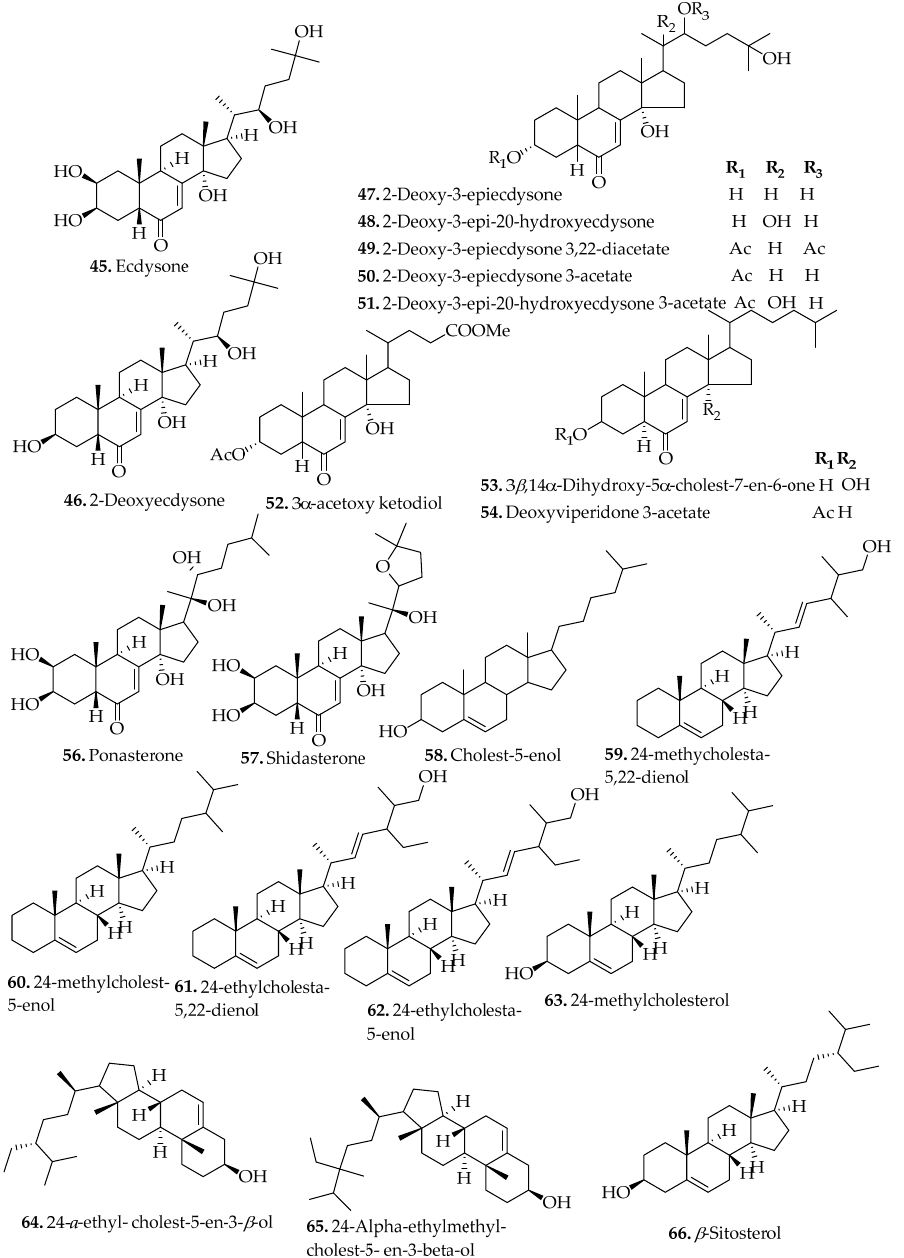
Figure 8. Chemical structures of sterols isolated from Blechnum species.